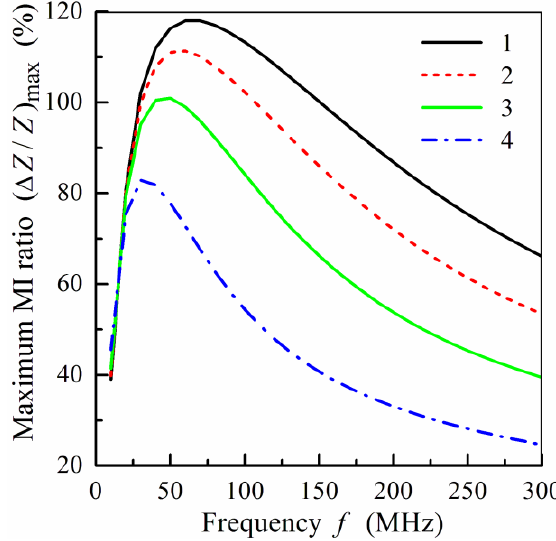
Figure 5. Frequency dependence of the maximum MI ratio, ( ∆ Z / Z ) max , for di ff erent symmetric film structures, m = n : curve 1, m = 4 and d 2 = 100 nm; curve 2, m = 9 and d 2 = 50 nm; curve 3, m = 19 and d 2 = 25 nm; curve 4, m = 49 and d 2 = 10 nm. Other parameters used for calculations are the same as in Figure 2.